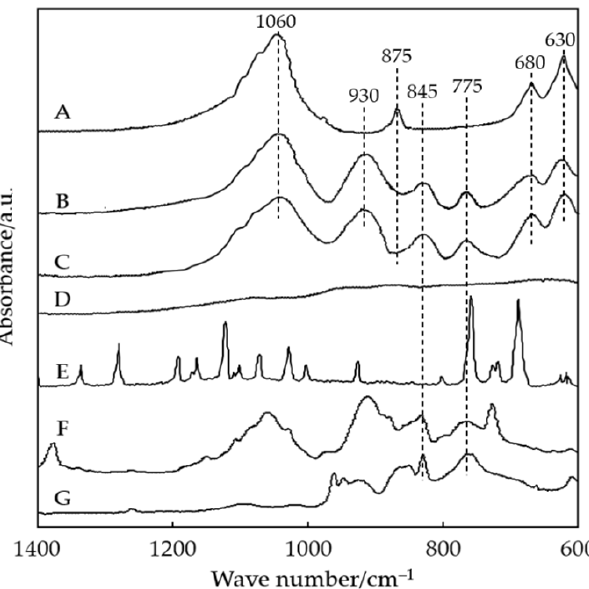
Figure 1. FT-IR spectra of various samples. (A): HAP; (B): PW-HAP; (C): Pd-PW-HAP; (D): PdCl 2 ;